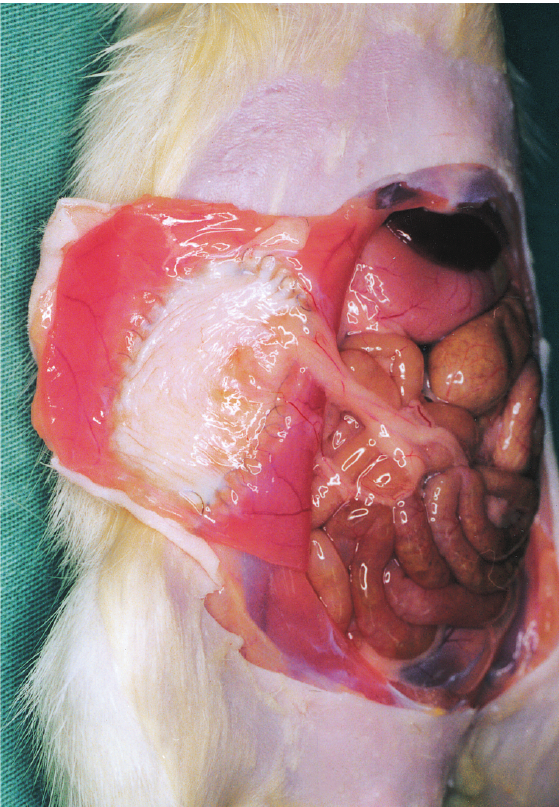
FIGURA 2 – Animal do grupo II aos 90 dias de pós-operatório, com aderência do omento ao pericárdio